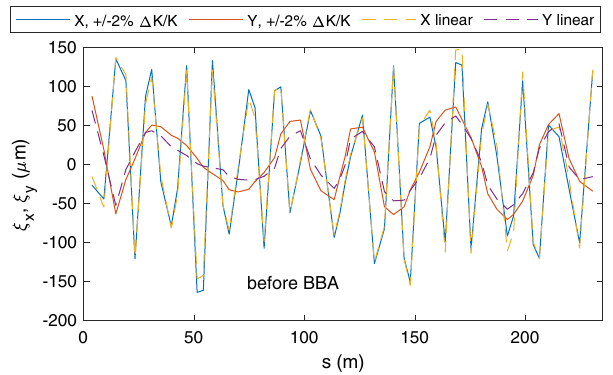
FIG. 7. The IOS in the SPEAR3 ring when the gradients of the selected 14 QF quadrupoles are varied by þ 2% or − 2% . The dashed lines are obtained by varying the gradients by only þ 0 . 02% or − 0 . 02% and scaling up the orbit shift linearly.